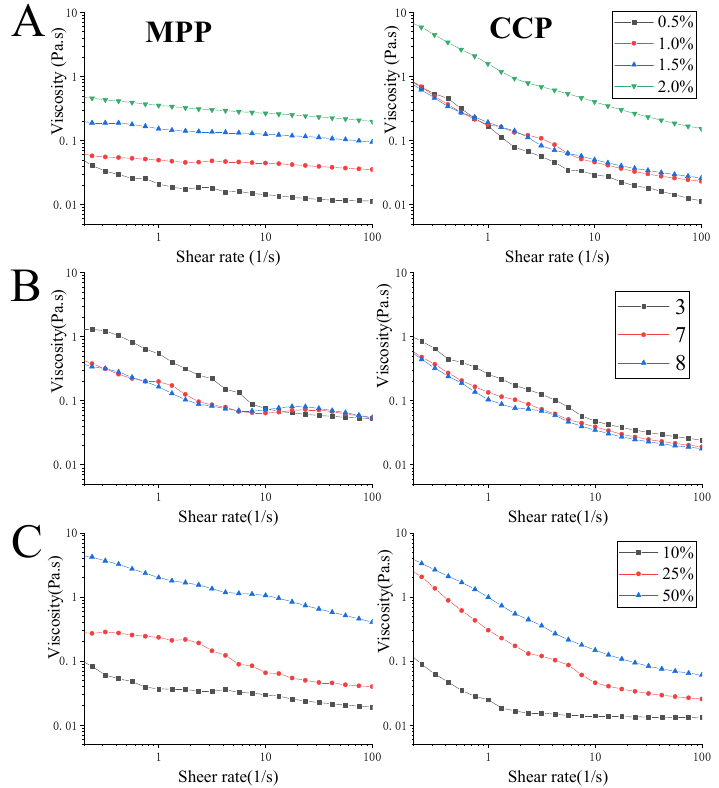
Figure 5. The effect of different pectin concentration ( A ), pH ( B ) and oil ratio ( C ) on the apparent viscosity of emulsion.